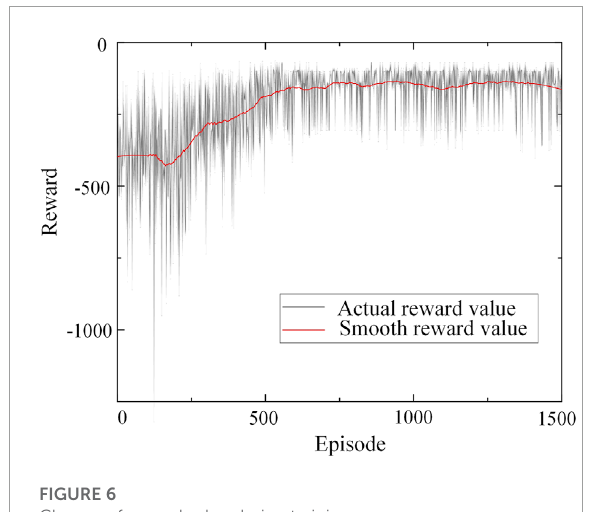
FIGURE 7 The number of excised movements in each training round.